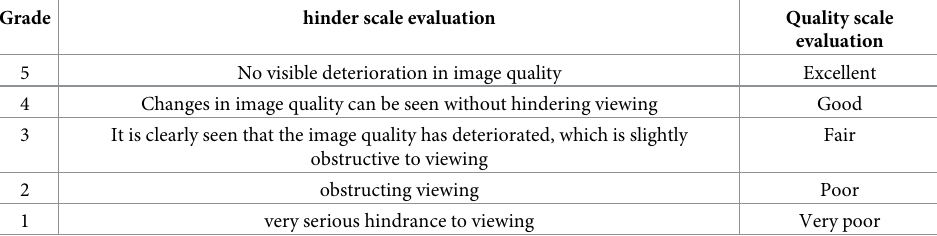
Table 3. Absolute